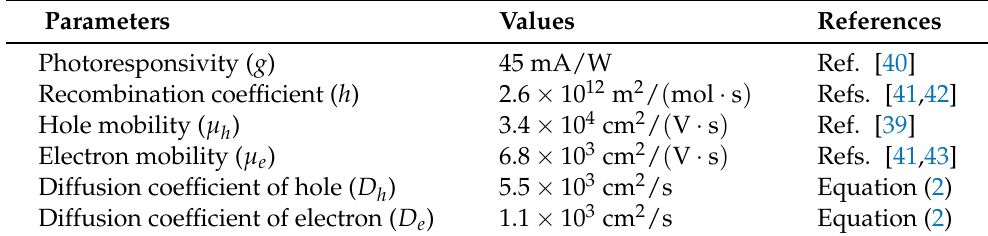
Table 1. Parameters for carriers’ diffusion model calculation